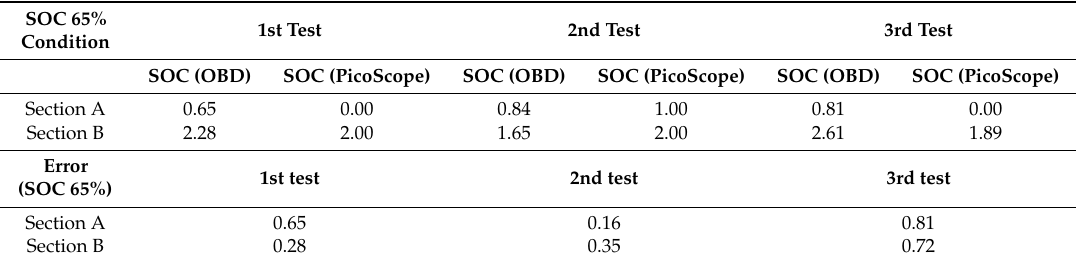
Table 5. Comparing Electric Charging Variation between SOC and PicoScope at SOC 65%.